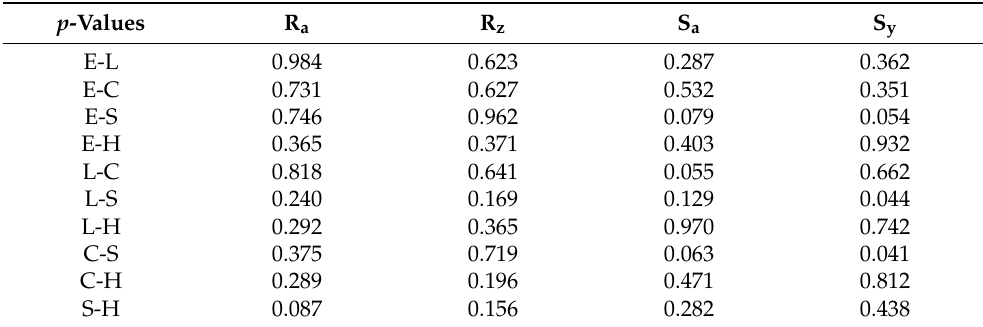
Table 4. p -Values related to material, after conditioning. E (Enamic), L (Lava Ultimate), H (Hyramic), S (Shofu), C (Cerasmart).